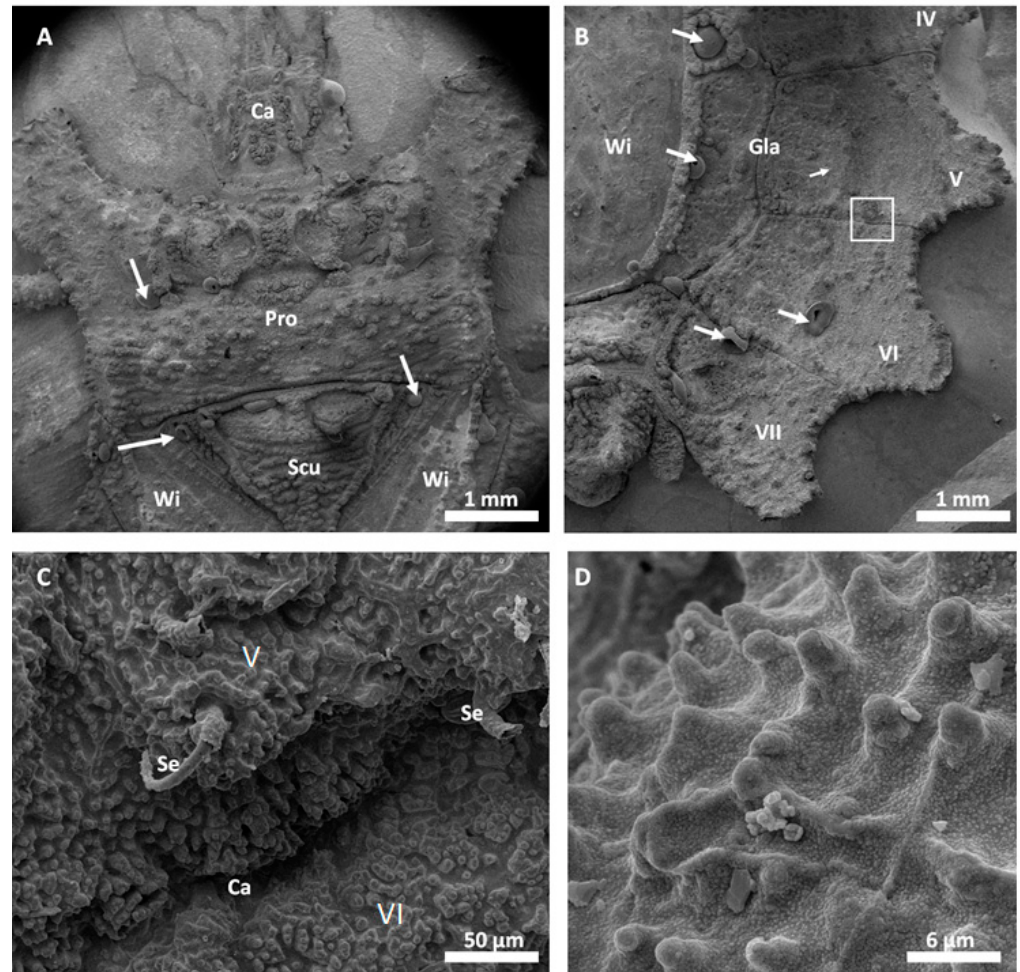
Figure 5. All-metal replica of D. lunatus . ( A ) SEM image of a replica of the dorsal–anterior part of D. lunatus . Morphological features can be identified: head (caput, Ca), pronotum (Pro), scutellum (Scu), and the sclerotized parts of the front wings (Wi). Bubble-like defects are indicated by white arrows. ( B ) SEM image of a replica of the dorsal–posterior part of the replica showing the connexival plates VI–VII with all of their corresponding intersegmental sutures, the glabrous area (Gla), and the wing membrane (Wi). Bubble-like defects can also be observed (white arrows). ( C ) Higher magnification SEM image from the white box in ( B ) shows he intersegmental suture between connexivum V and VI (capillary, Ca), the surrounding microstructured surface, and setae (Se). ( D ) Higher magnification SEM image of the surface microstructure.